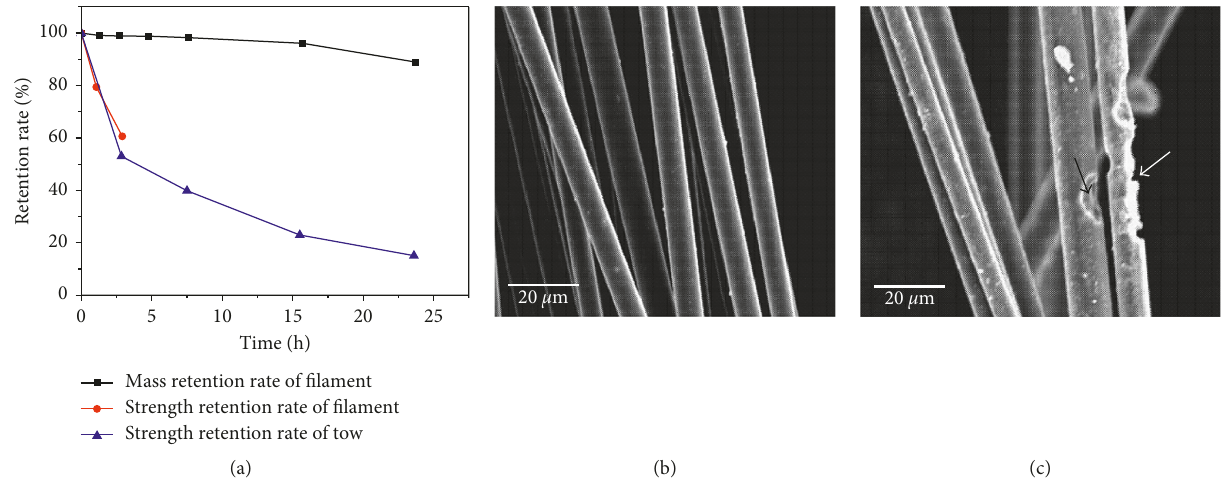
Figure 1: The alkali resistance of BF in 2mol/L NaOH solution at 80 ° C: (a) curves showing the variation of the mass and strength of the fiber with increasing alkali corrosion time and SEM images of the fibers (b) before and (c) after the alkali corrosion [38].